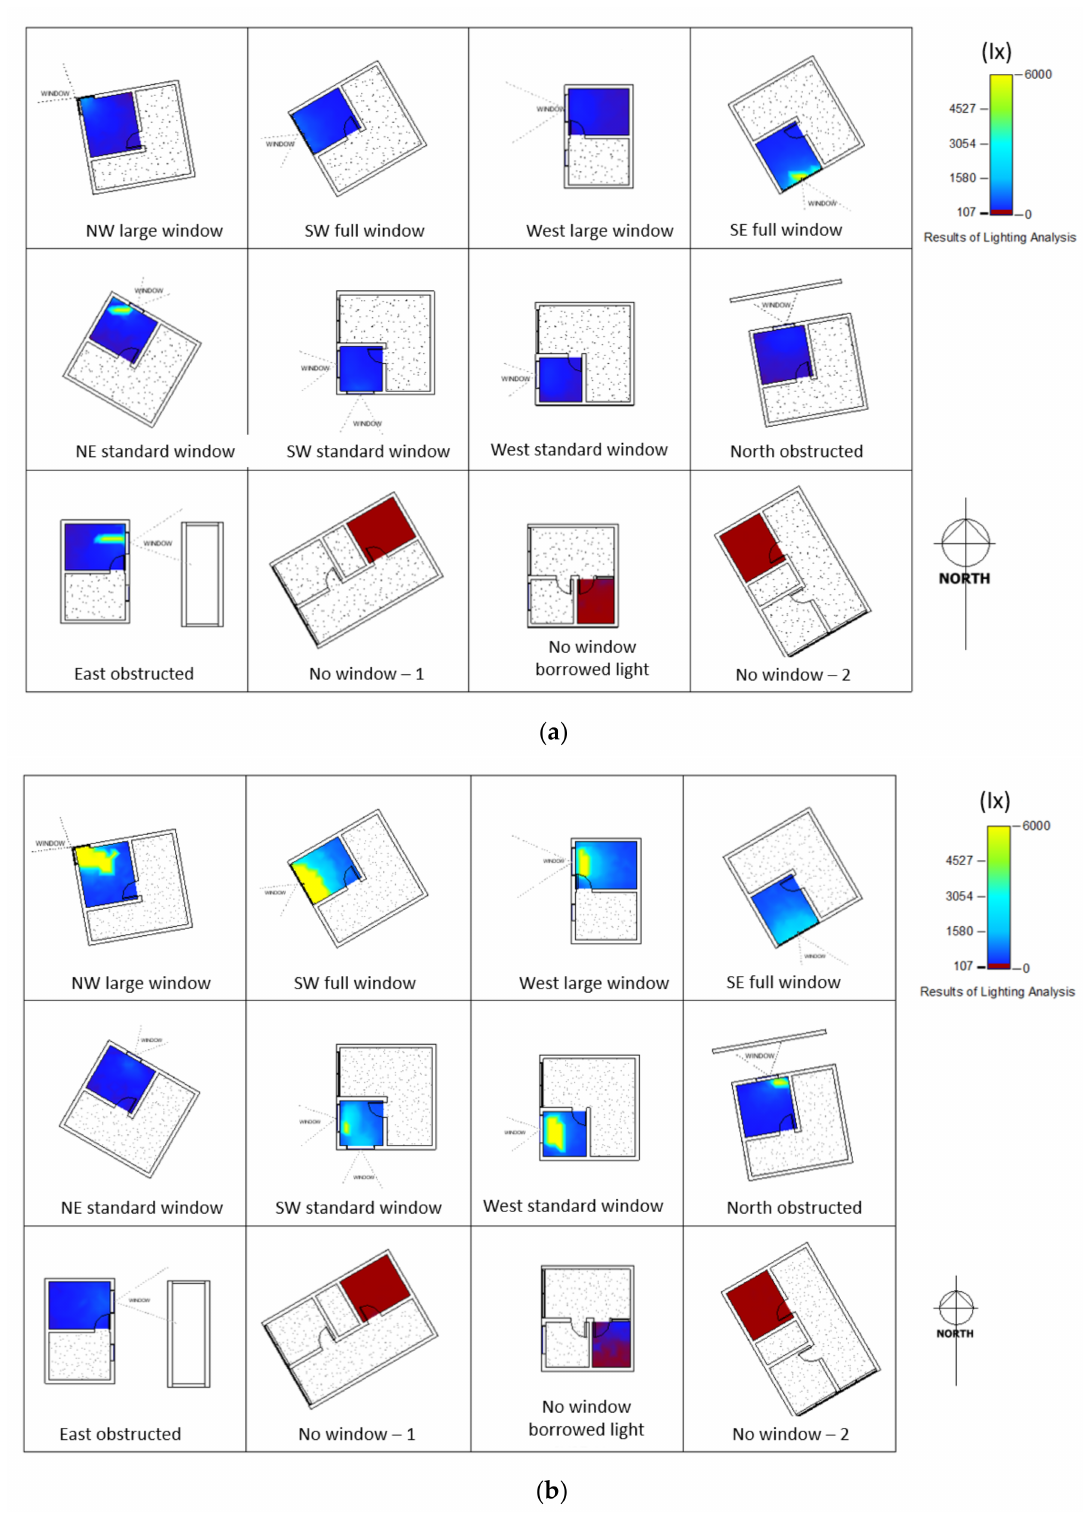
Figure 5. Distribution of illuminances: ( a ) 9 a.m. ( b ) 3